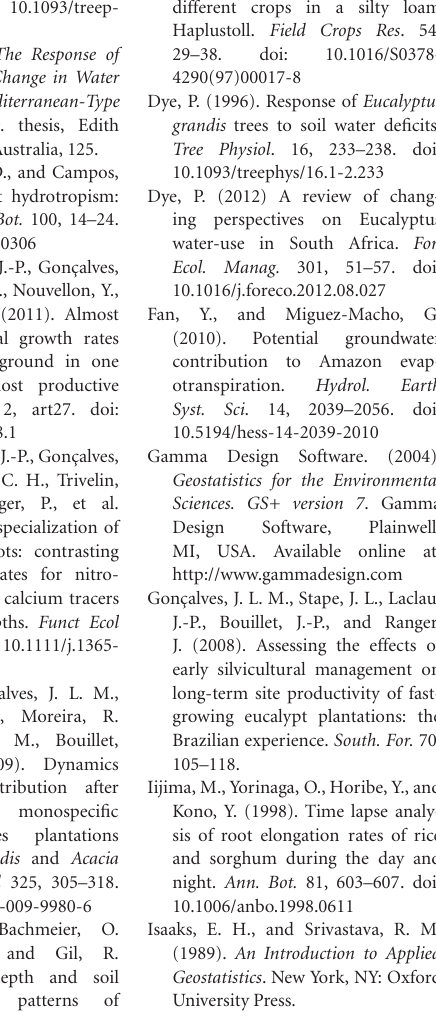
Table Level in a Mediterranean-Type Environment . Ph.D. thesis,